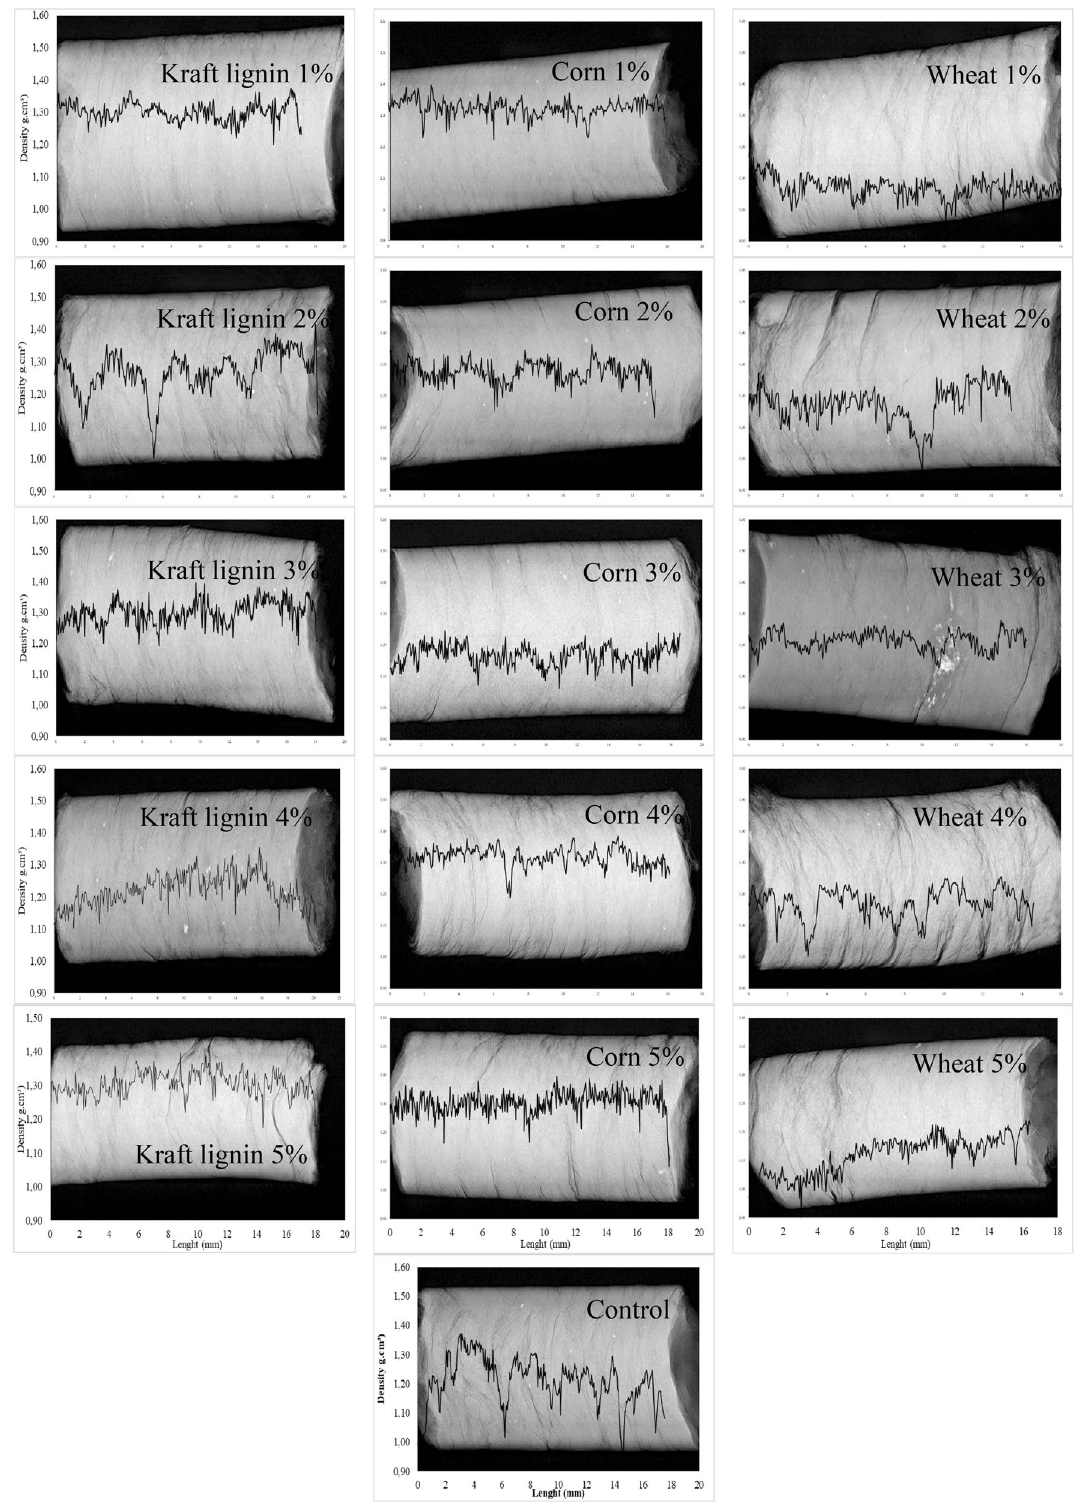
Figure 1. Longitudinal variation of pellet density with different proportions of the additives kraft lignin and corn and wheat